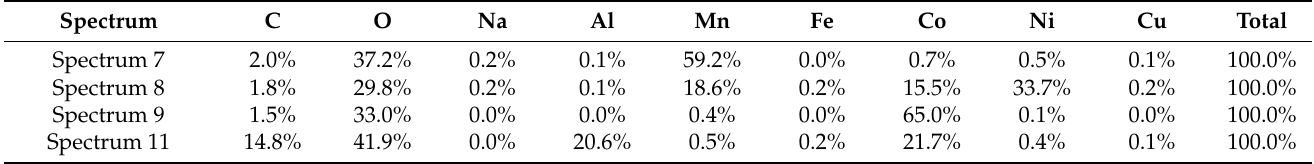
Table A1. Metal weight percentage of identified spectrums.